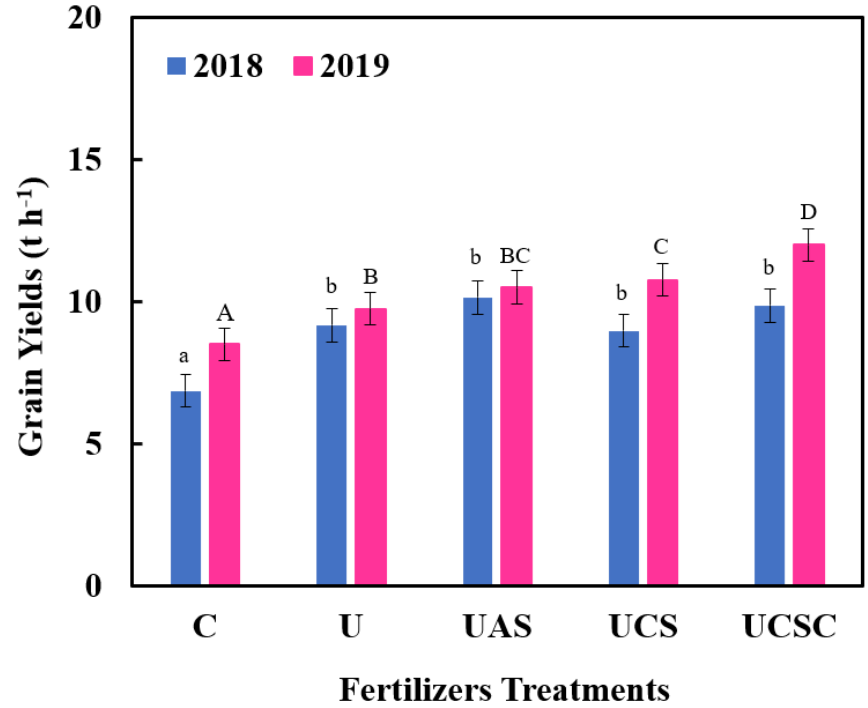
Figure 4. The effect of the urea-sulfur fertilizers on grain yields for 2 years. (2018–2019). Control U = Urea, UAS = Urea + ammonium sulfate, UCS = Urea + CaSO 4 and UCSC = Urea cocrystal (CaSO 4 .4urea). Note 1. Columns followed by the same letter with the same size are not different ( p < 0.05) according to Duncan’s multiple range test at the 5% level. Note 2. No significant differences between both seasons.